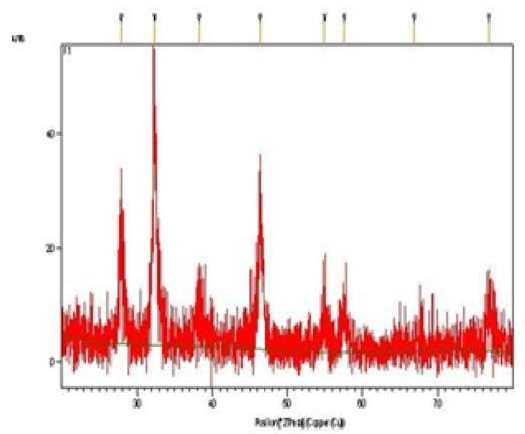
Fig. 6. Atomic force microscopy images of Bio - AgNP Fig. 6 Atomic force microscopy images of Bio - AgNP synthesized by Fusarium solani synthesized by Fusarium solani showing spherical nanoparticles without agglomeration showing spherical nanoparticles without agglomeration.